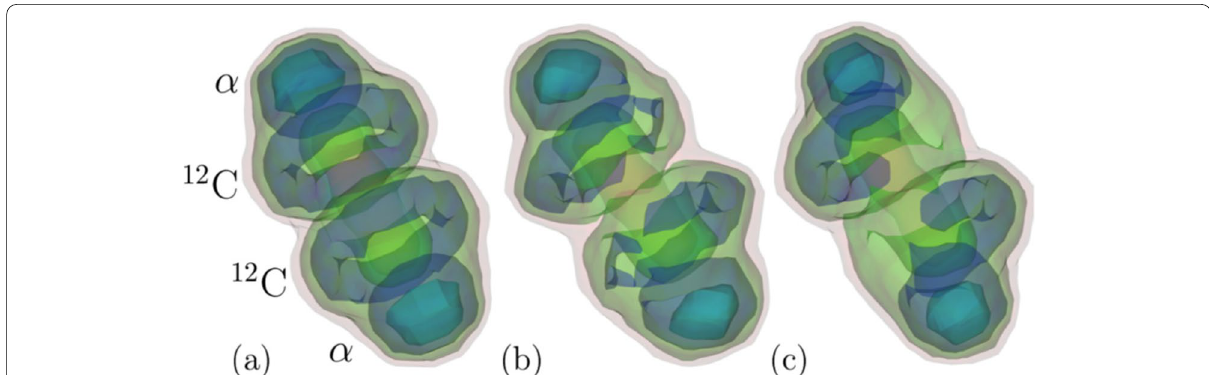
16 O collision at E 300 fm / c in 16 O cm = 20 MeV for three values of the impact parameter: b = +